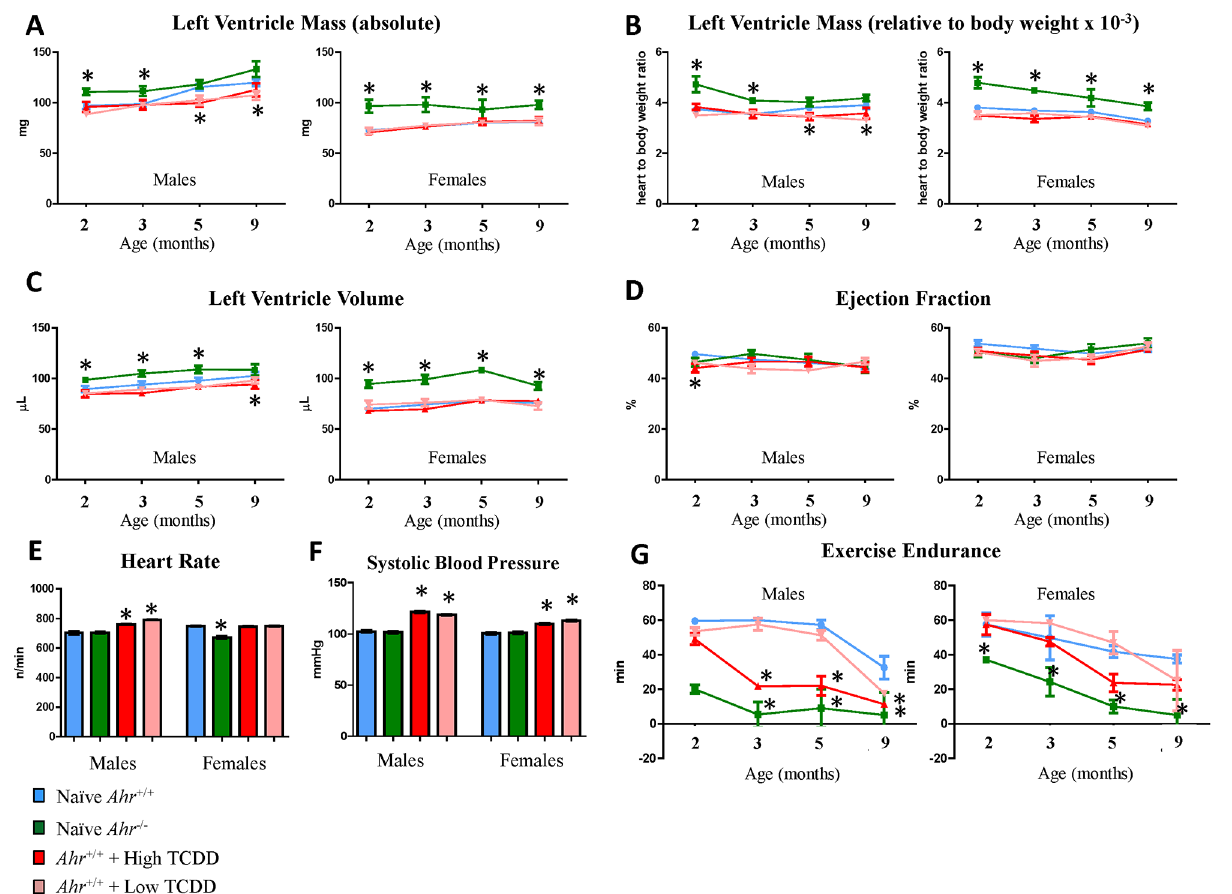
Fig 1. In utero disruption of AHR signaling affects the adult cardiovascular function. Na ï ve Ahr +/+ and Ahr -/- and high and low dose TCDD-exposed mice were assessed for cardiovascular function on postnatal days (PND) 60, 90, 150, and 270, corresponding to 2, 3, 5, and 9 months of age, respectively. Absolute left ventricle mass (mg) (A), normalized left ventricle mass (B), left ventricle volume ( μ L) (C), and ejection fraction (%) (D) were derived from echocardiographic examination of heart function. Conscious heart rate (F) and systolic blood pressure (G) were determined by the tail-cuff method on PND 270. Exercise endurance (minutes) was assessed by forced treadmill exercise on 2, 3, 5, and 9 months of age. All data is expressed as mean ± SEM where * p <